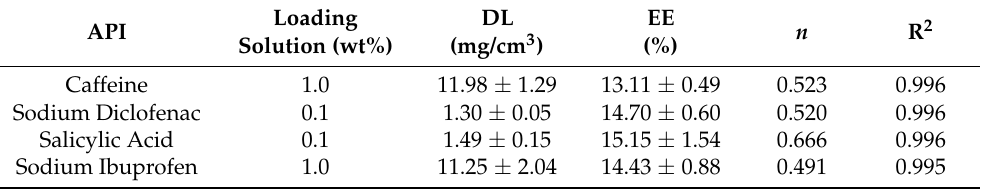
Table 2. Concentration of loading solutions, drug loading (DL, mg/cm 3 ), entrapment efficiency (EE, %), and Korsmeyer–Peppas model parameters obtained from the in vitro release kinetics of Na5 1 * 4 hydrogels; R 2 , regression coefficient; n , release exponent. API